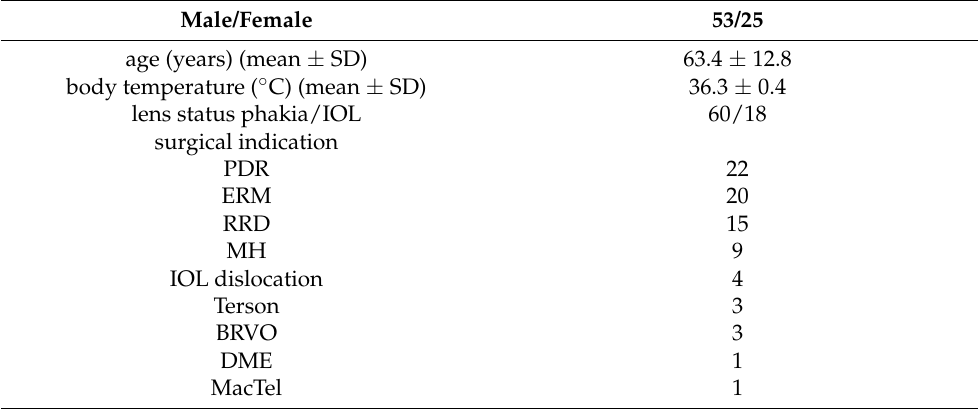
Table 1. Clinical characteristics of the